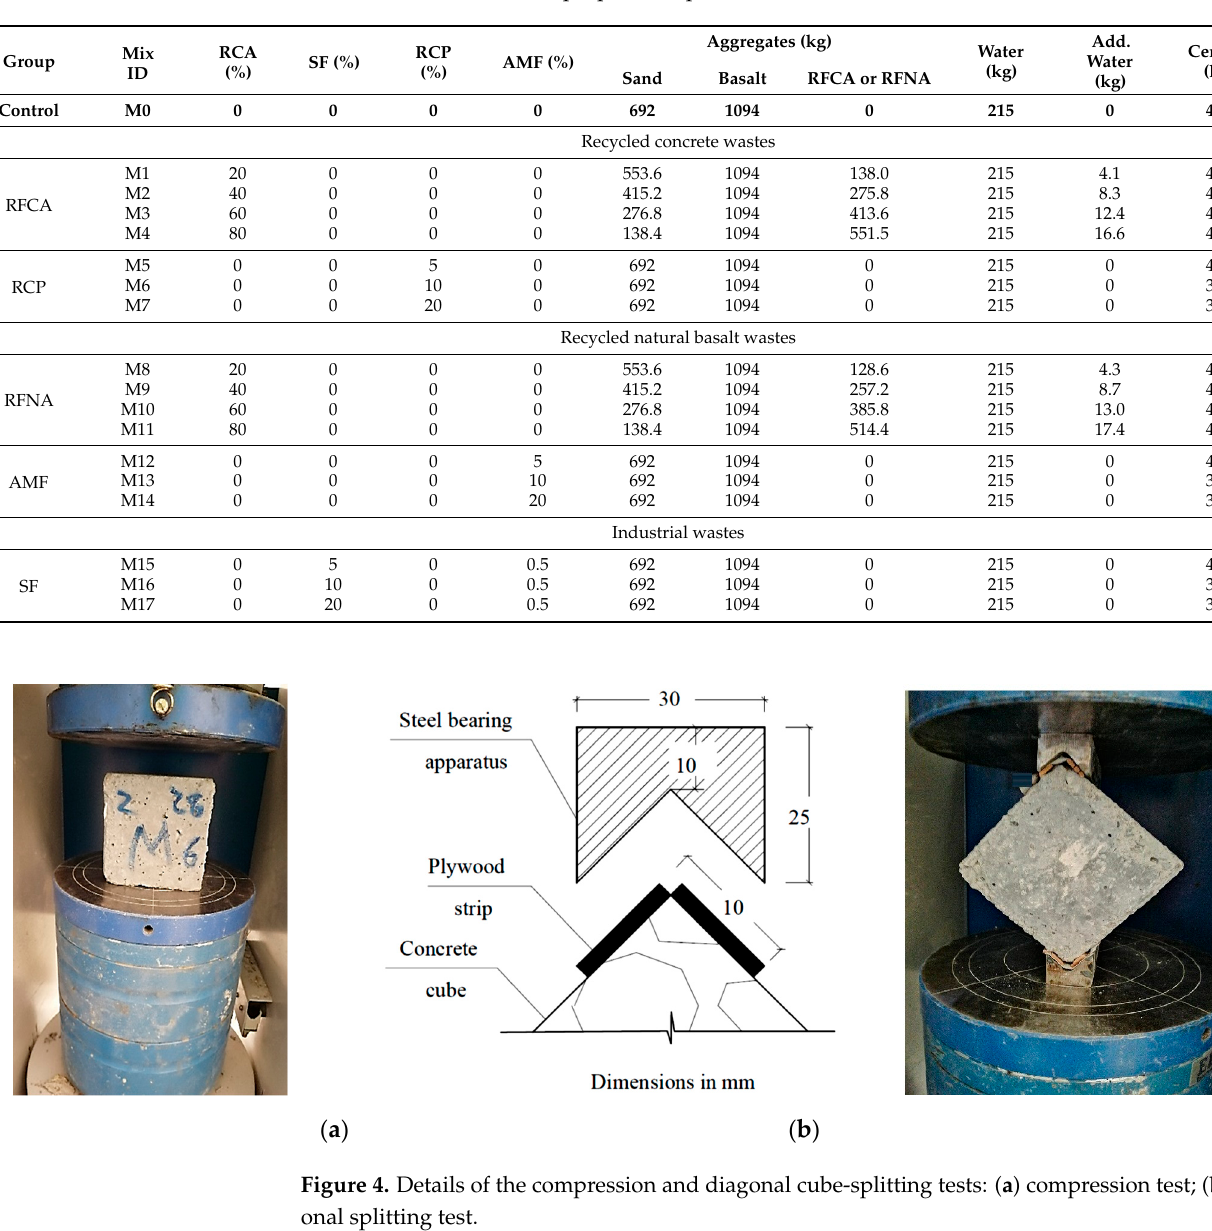
Table 3. Concrete mixture proportions per 1 m 3 .